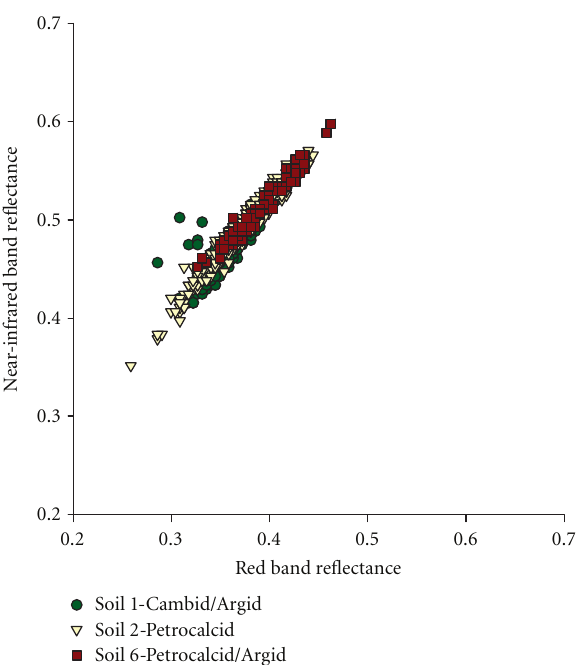
Figure 5: Soil line representing three mapped soil classes based on Landsat 7 ETM+ reflectance values corrected for atmospheric e ff ects. Values are plotted for all pixels and support ancillary evidence to demonstrate that vegetation cover was very low and did not contribute substantially to the reflected spectral signal. See Table 4 for soil classification of field